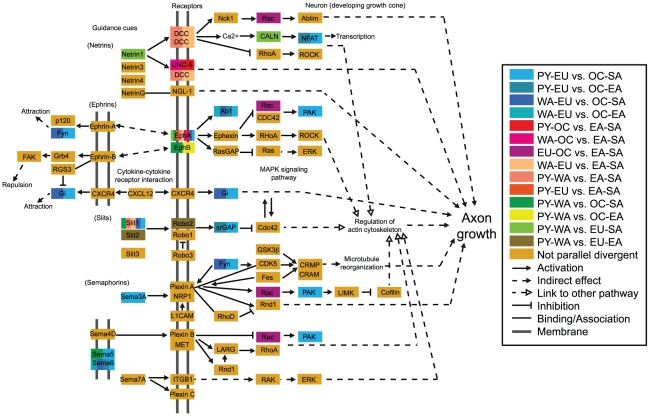
Axon guidance pathway highlighting genes containing parallel divergent SNPs.Most divergence comparisons showed parallel divergent genes in this pathway (enrichment = 1.27), and the PY-EU vs. OC-SA divergence comparison was particularly enriched (enrichment = 2.67) with eleven parallel divergent genes. In this pathway, receptors in the axon growth cone sense guidance cues and signal downstream processes that regulate the cytoskeleton and determine which direction the axon will grow, ultimately influencing the development of neuronal networks. “Positive regulation of axonogenesis” is also an enriched GO term (Table S3). Ephrin receptor EPHA6 in particular overlaps parallel divergent SNPs in most divergence comparisons and is still observed for “PY-EU vs. EA-SA” and “WA-EU vs. EA-SA” at thresholds as low as 0.5%. Although there are more enriched genes in this pathway than in the pathways in Table S3, the overall per-SNP enrichment is slightly lower for this pathway than for the Table S3 pathways, in part due to differences in mean gene length.